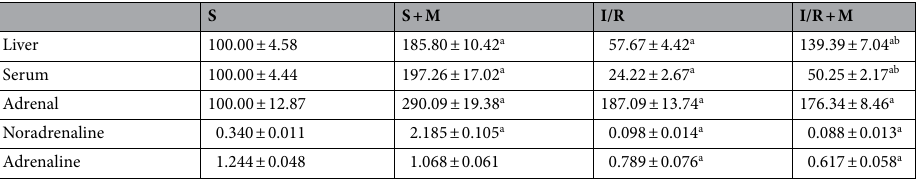
Table 4. The ascorbic/dehydroascorbic acid ratio (AA/DHA, % of sham) in the serum, liver, and adrenal glands, and adrenal noradrenaline and adrenaline content (µg/mg tissue). Experimental group abbreviations: S sham-operated rat group, S + M sham-operated + meldonium rat group, I/R ischemia/reperfusion rat group, I/R + M ischemia/reperfusion + meldonium rat group. The number of animals per experimental group: n = 8. The data are given as mean ± standard error of the mean. Minimal significant level: p < 0.05. Significantly different: a in respect to S group; b in respect to I/R